Question: What type of chart is this?
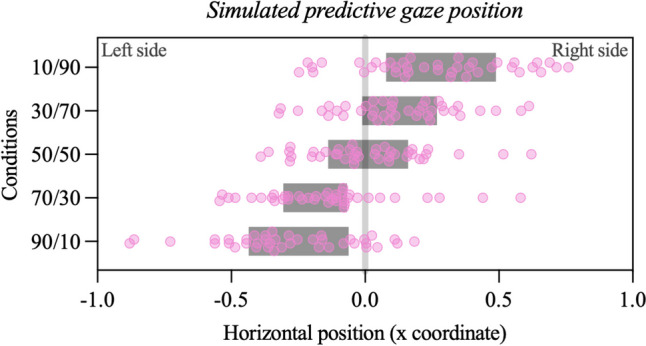
Answer: box